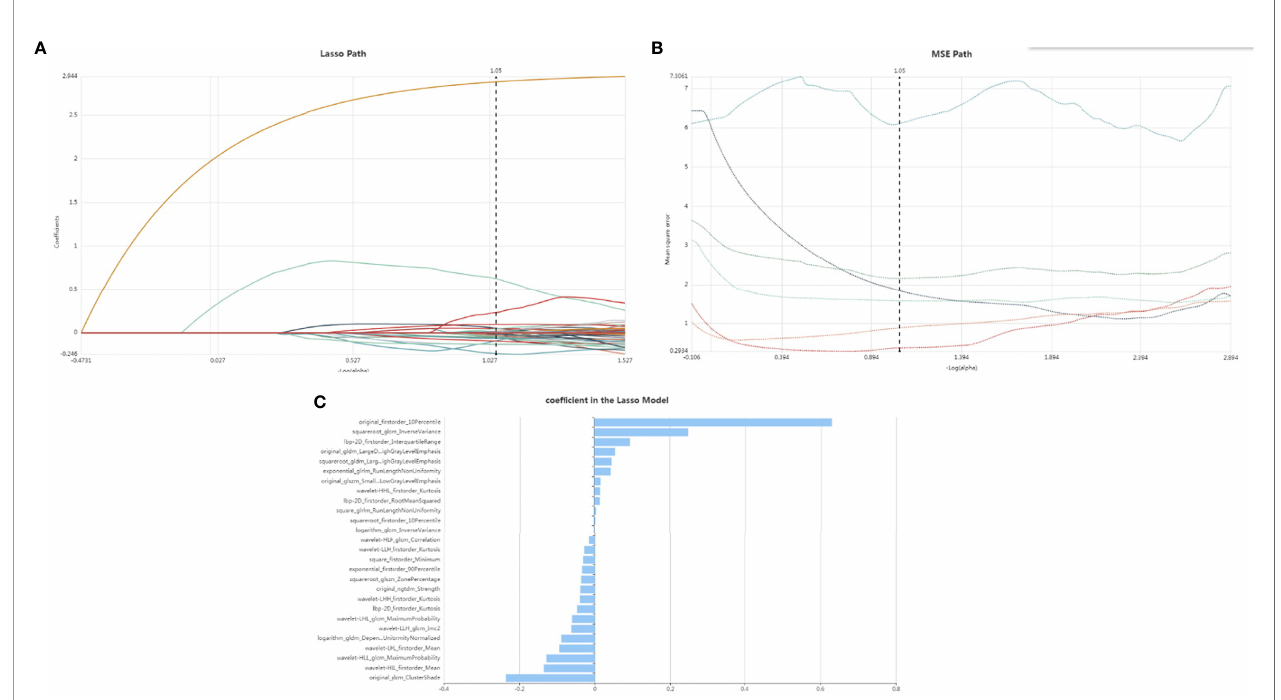
FIGURE 2 | Lasso althorithm on feature selection. (A) Lasso path; (B) MSE path; (C) coef fi cients in Lasso model. With Lasso model, 27 features were selected according to the optimal